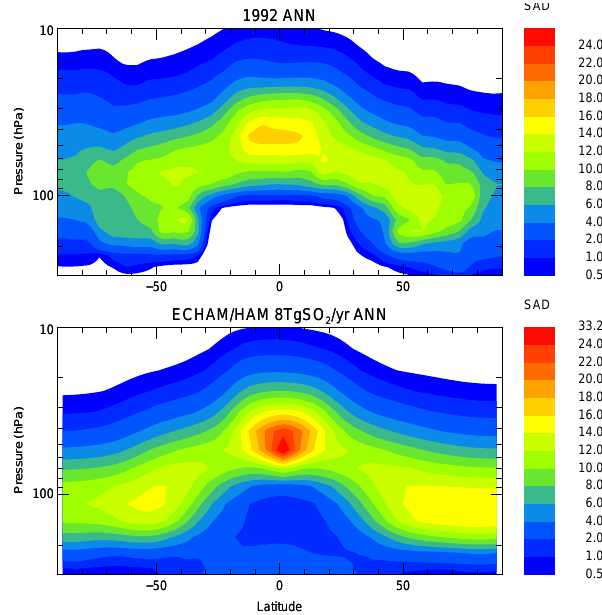
Figure 2. Top panel: 1992 annual average surface area density (SAD) distribution in µ m 2 /cm 3 derived using the CCMI stratospheric aerosol data set (Eyring et al., 2013), following the 1991 Mt. Pinatubo volcanic eruption. Bottom panel: steady-state prescribed aerosol distribution of the proposed GeoMIP experiment, based on a 8 Tg SO 2 /year emission scenario using the ECHAM5-HAM model (Niemeier et al., 2013).